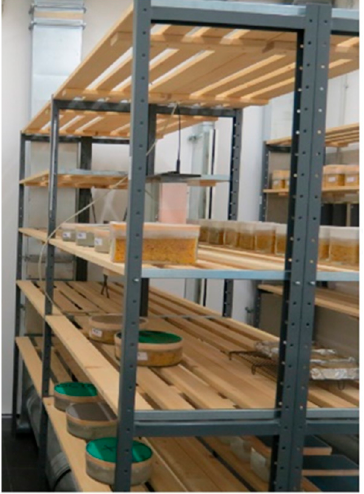
Figure 19. Shelving in the interior of test room at IBP Germany.